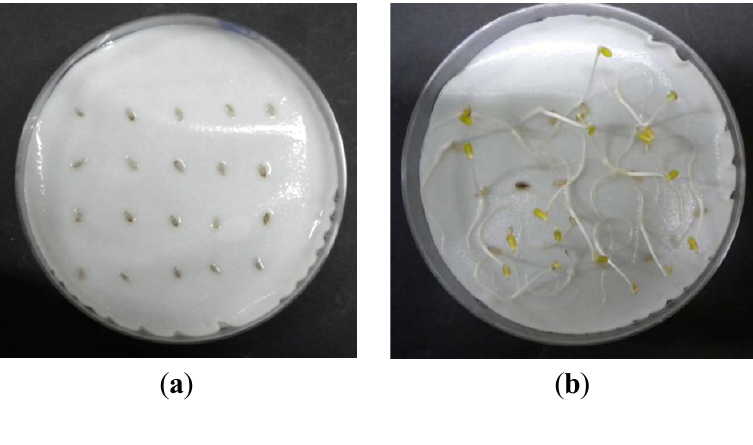
Figure 2. Seed viability test of lettuce seeds before germination ( a ) and after germination ( b